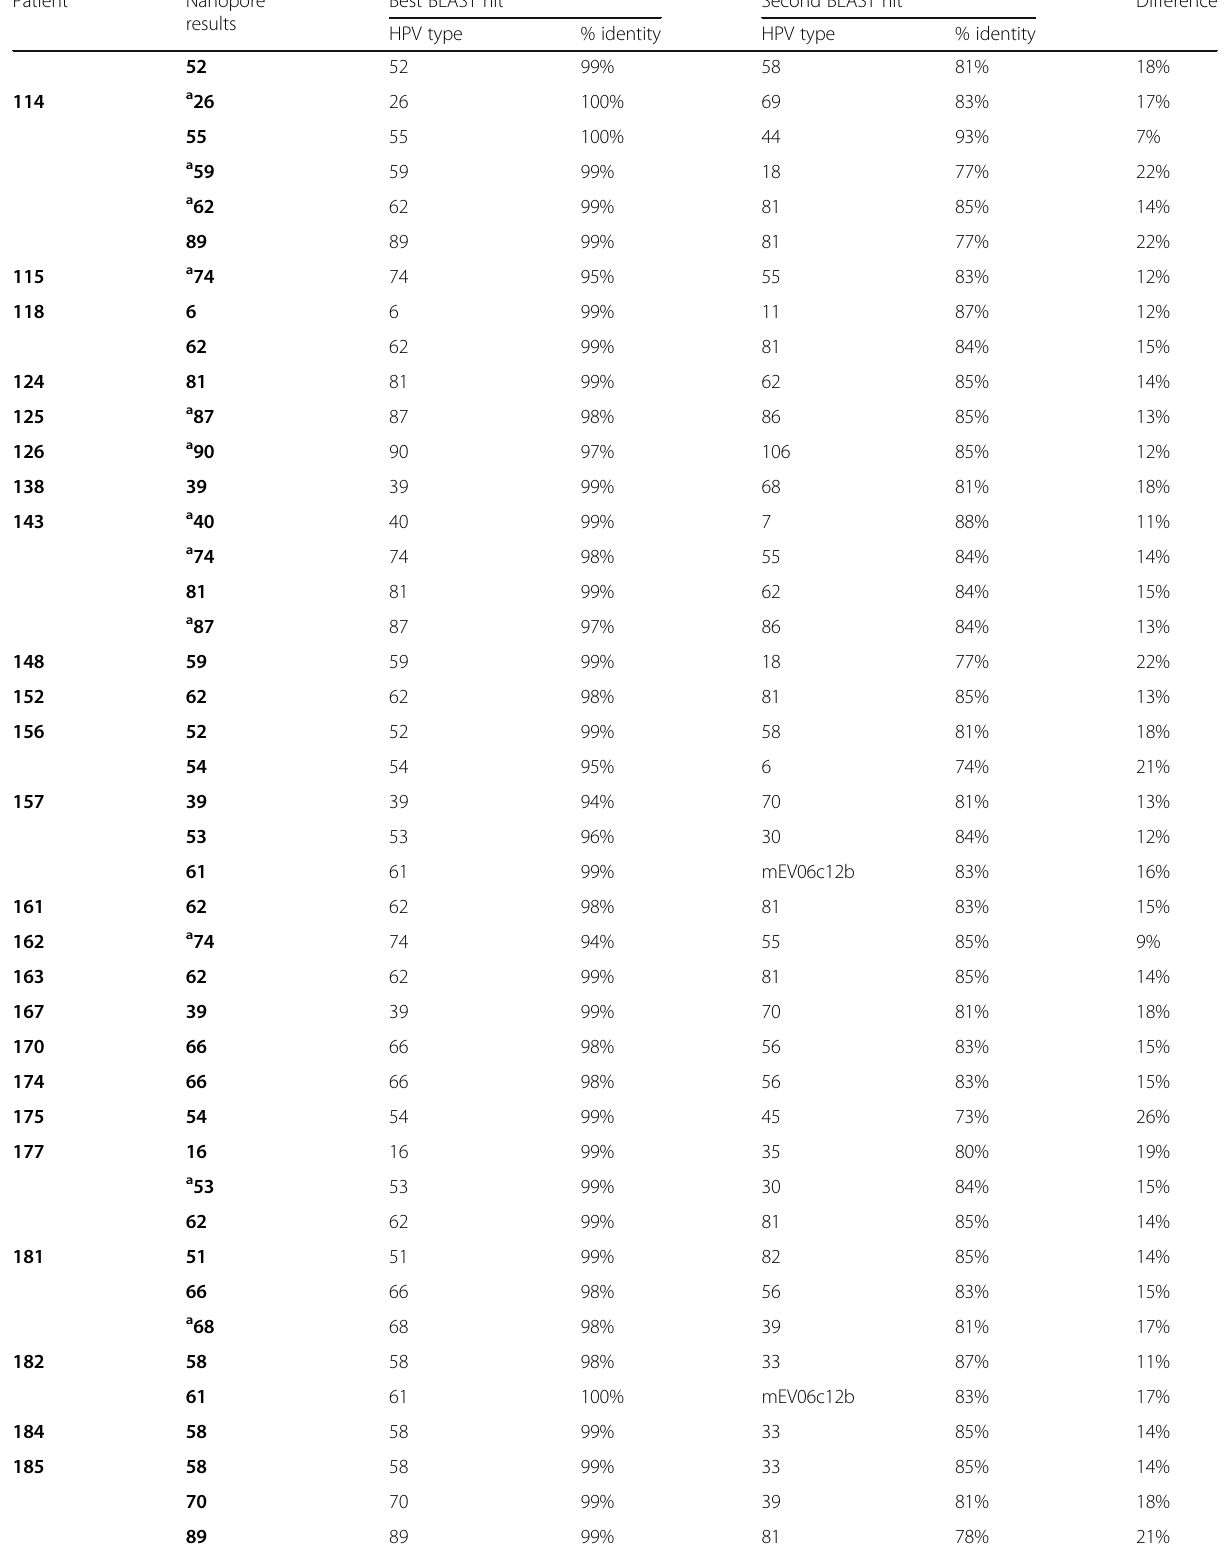
Table 7 Percentage of identity of Nanopore consensus sequences to HPV reference genomes (Continued)